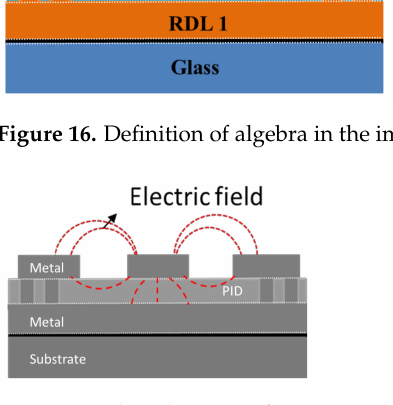
Figure 17. The schematic of GCPW with electric